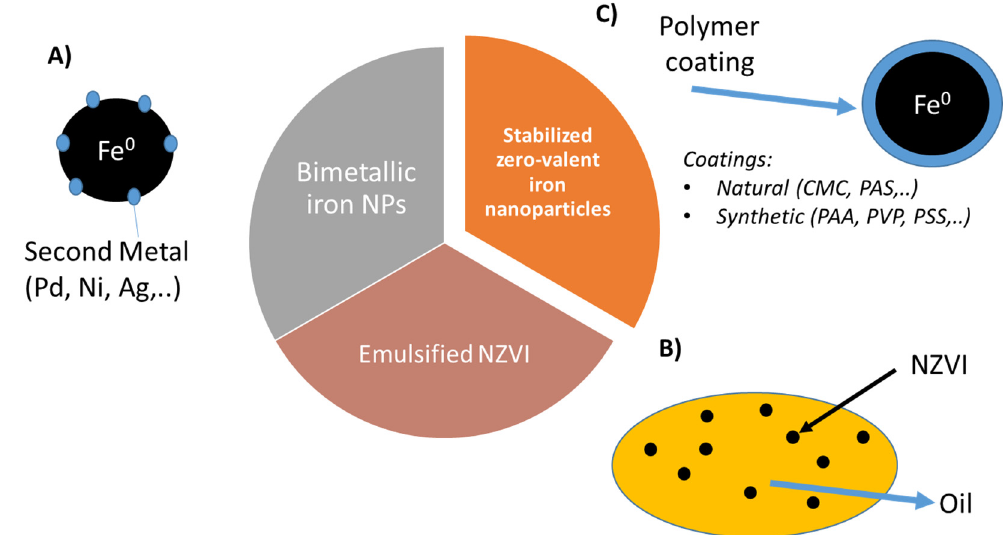
Figure 2. Main NZVI groups used for environmental applications: ( A ) Bimetallic iron nanoparticles, ( B ) emulsified NZVI and ( C ) stabilized NZVI.